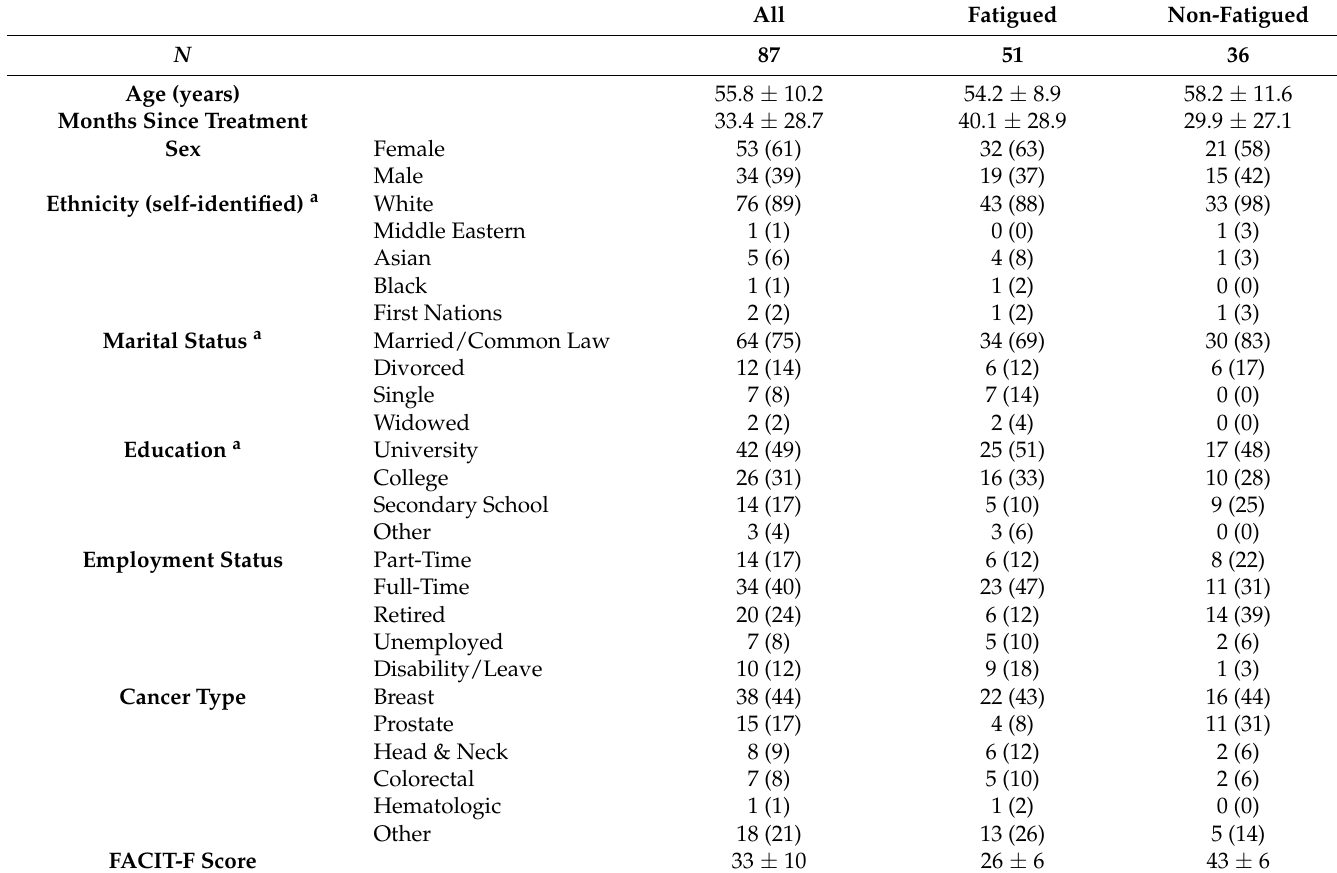
Table 1. The characteristics of the